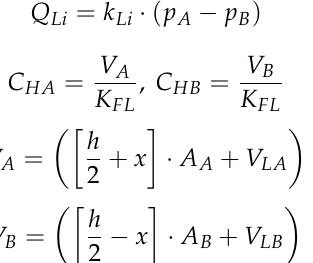
Figure 8. Schematic diagram of cylinder parameters.